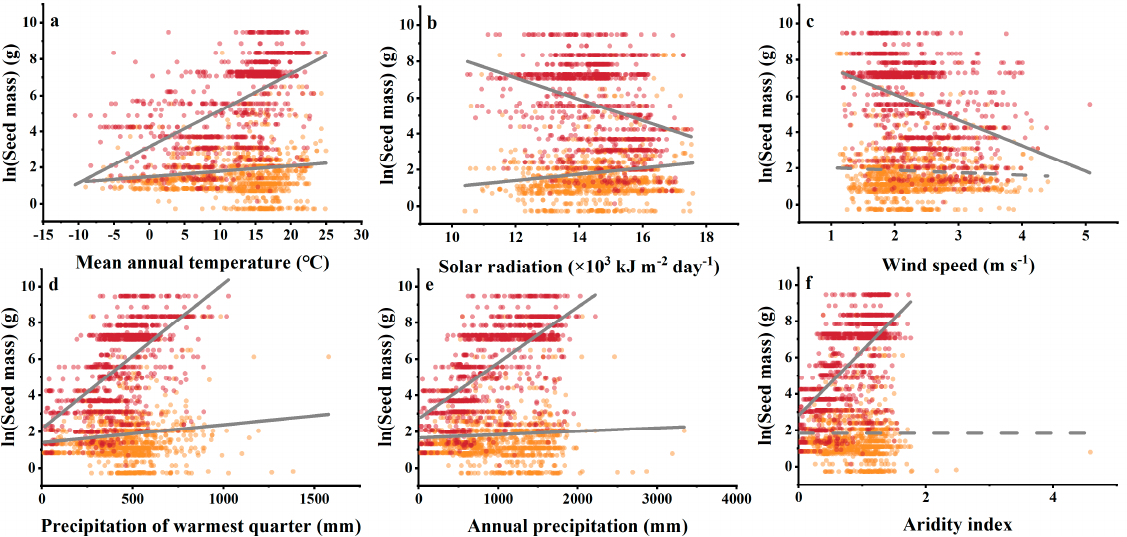
Figure 5. Relationships between the minimum and maximum seed masses of gymnosperms and ( a ) Mean annual temperature; ( b ) Solar radiation; ( c ) Wind speed; ( d ) Precipitation of the warmest quarter; ( e ) Annual precipitation and ( f ) Aridity index. The red dots indicate the maximum value of gymnosperm seed mass and the orange dots indicate the minimum value. The solid line indicates a significant linear regression ( p < 0.05), while the dashed line indicates an insignificant linear regression ( p > 0.05).